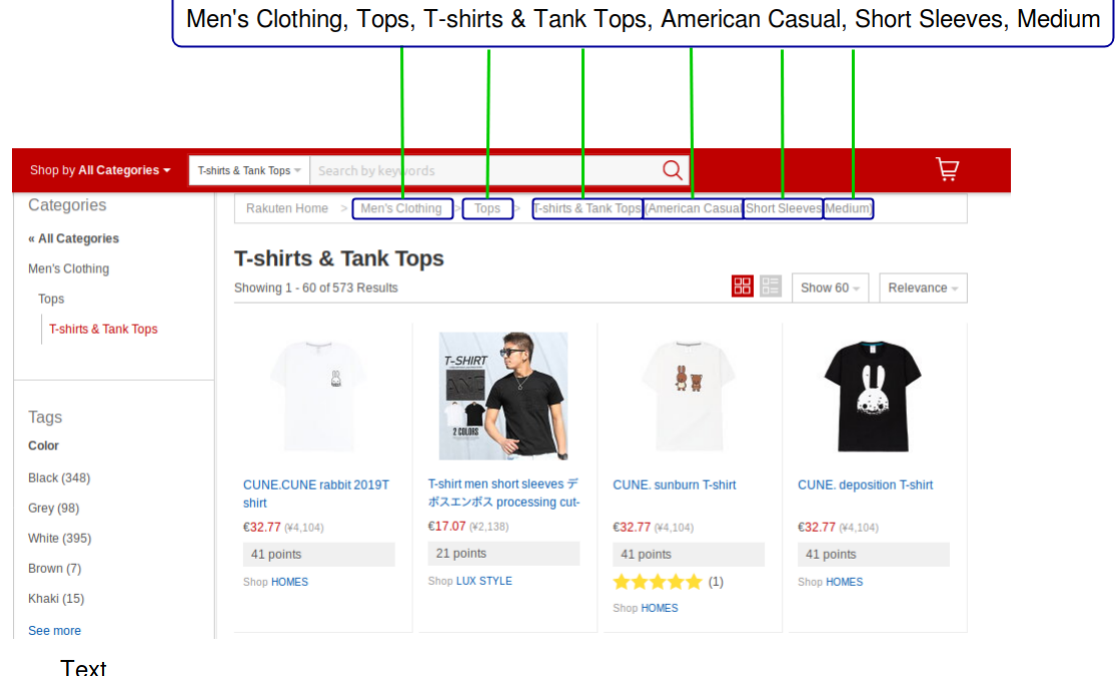
Figure 1. Snapshot of a T-shirt search page taken from